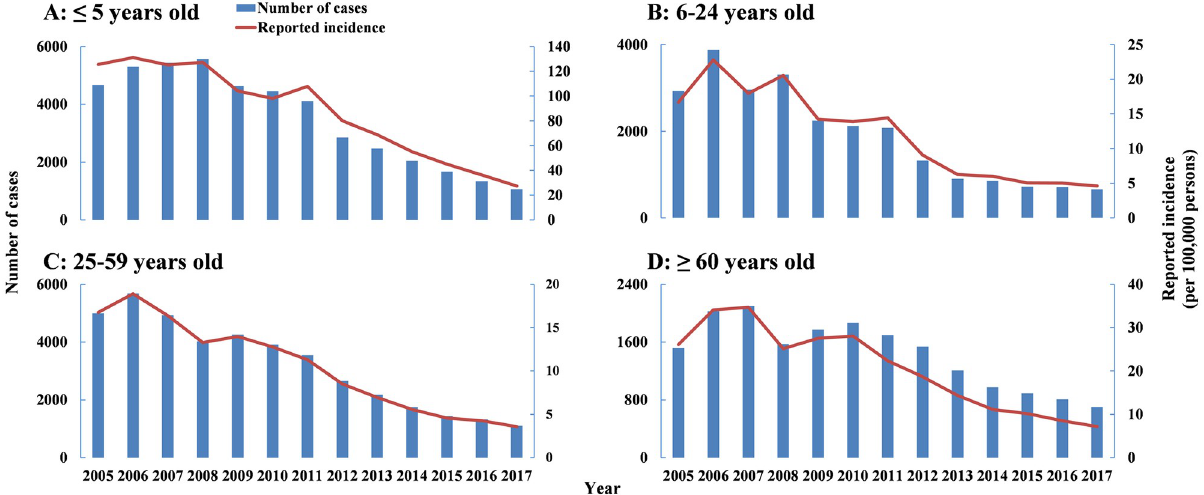
Fig 4. Reported cases and incidence of shigellosis in different age groups from 2005 to 2017 in Hubei Province. A) � 5 years old. B) 6–24 years old. C) 25–59 years old. D) � 60 years old.